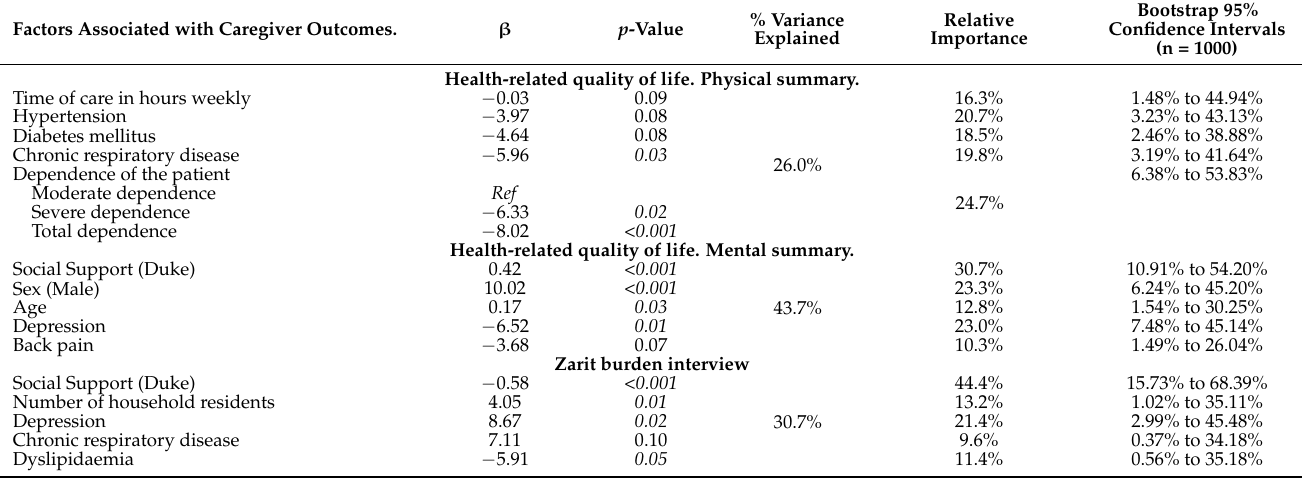
Table 5. Multivariate regression models of factors associated with caregiver